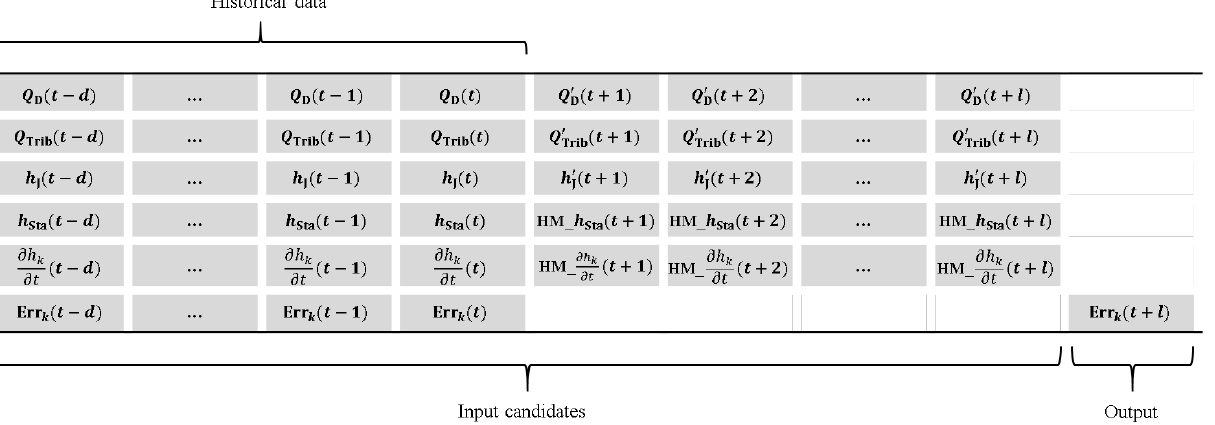
Figure 9. Input candidates and output for ANN3.